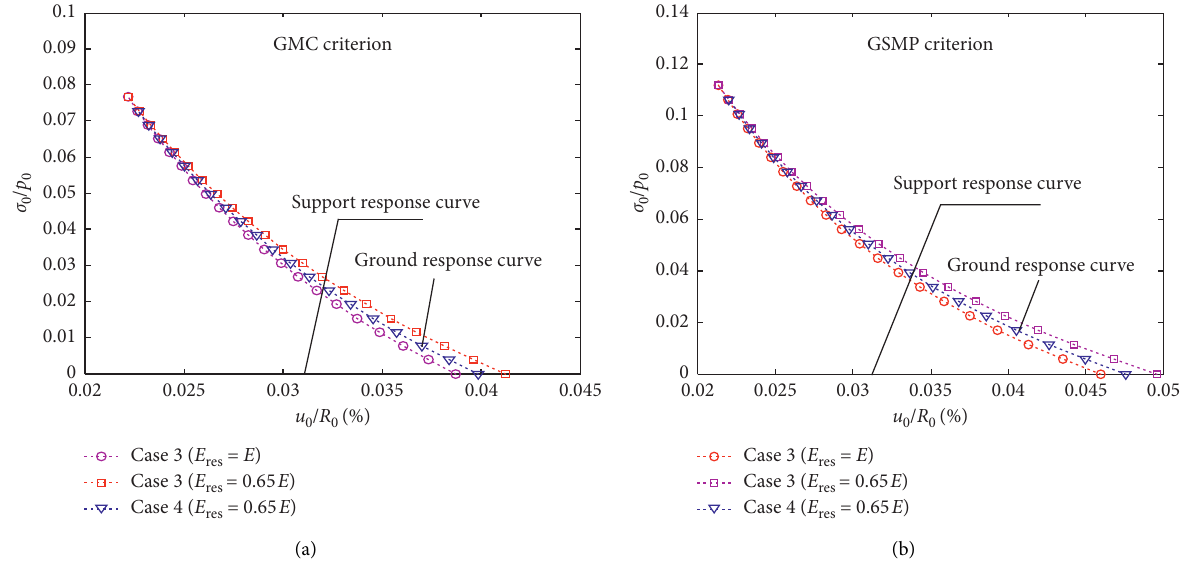
Figure 13: The effect of rock mass damage on the ground response